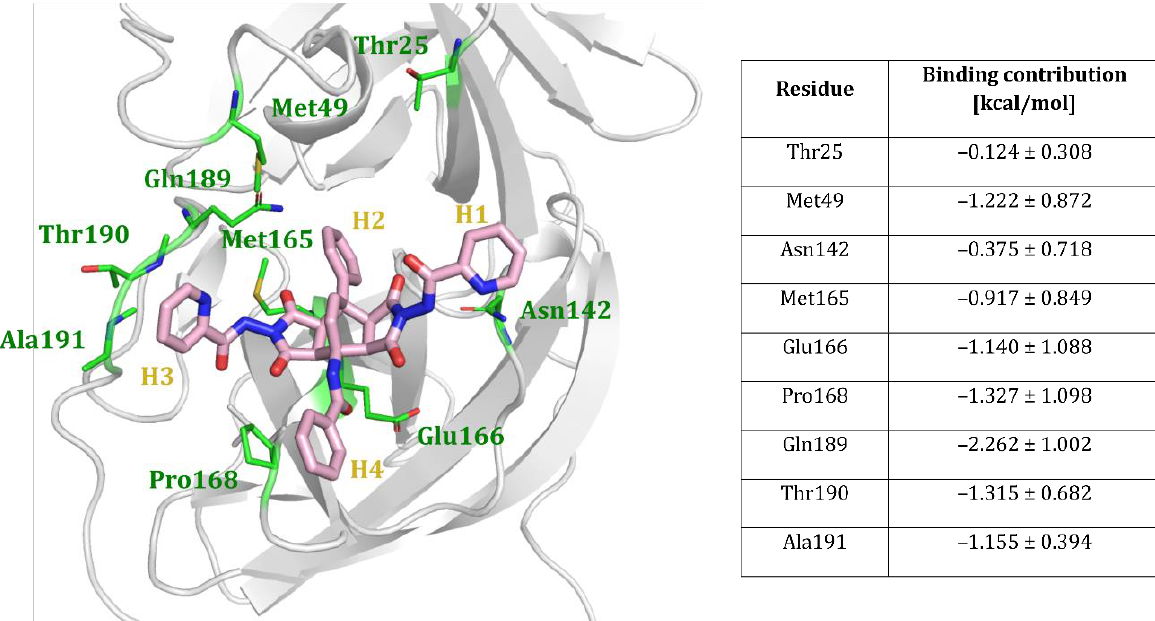
Figure 6. Per-residue energy decomposition of binding free energy calculated by MM/GBSA method. Compound 11a is shown in an orientation closer to domain II of 3CL pro and depicted in pink, and the residues that contribute the most to its binding are in green.